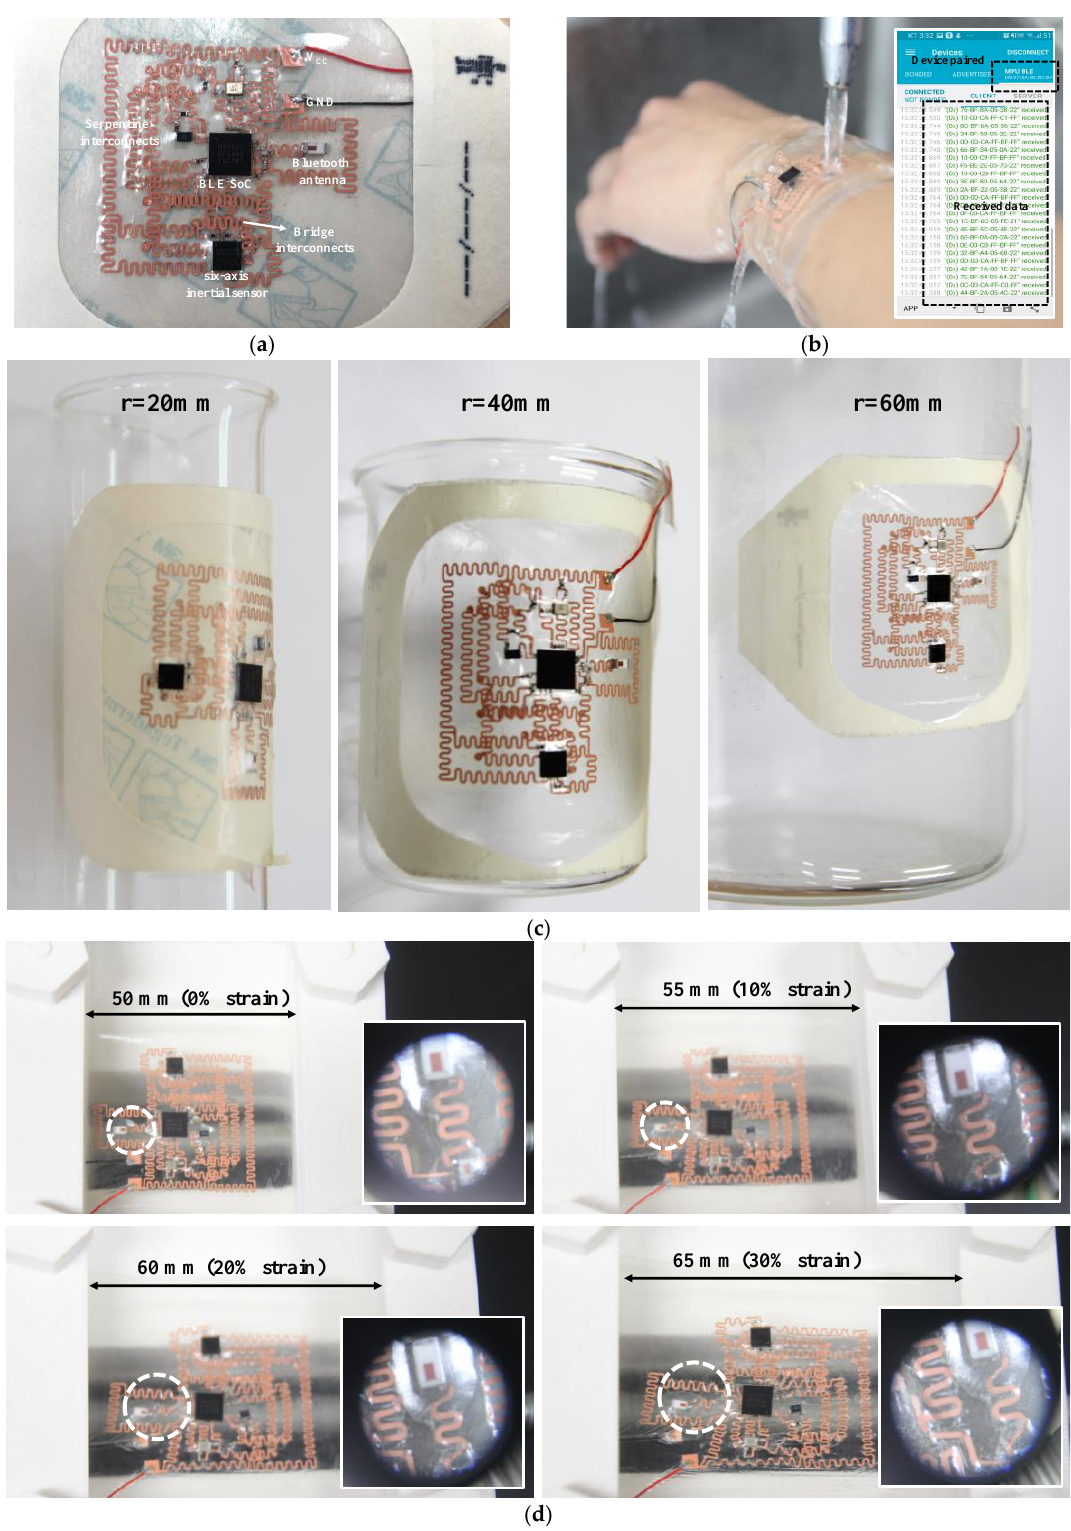
Figure 4. Implementation results. ( a ) Wireless epidermal six-axis IMU; ( b ) waterproof experimental results; ( c ) flexibility test results; ( d ) stretchability test results with 0% to 30% tensile strain.